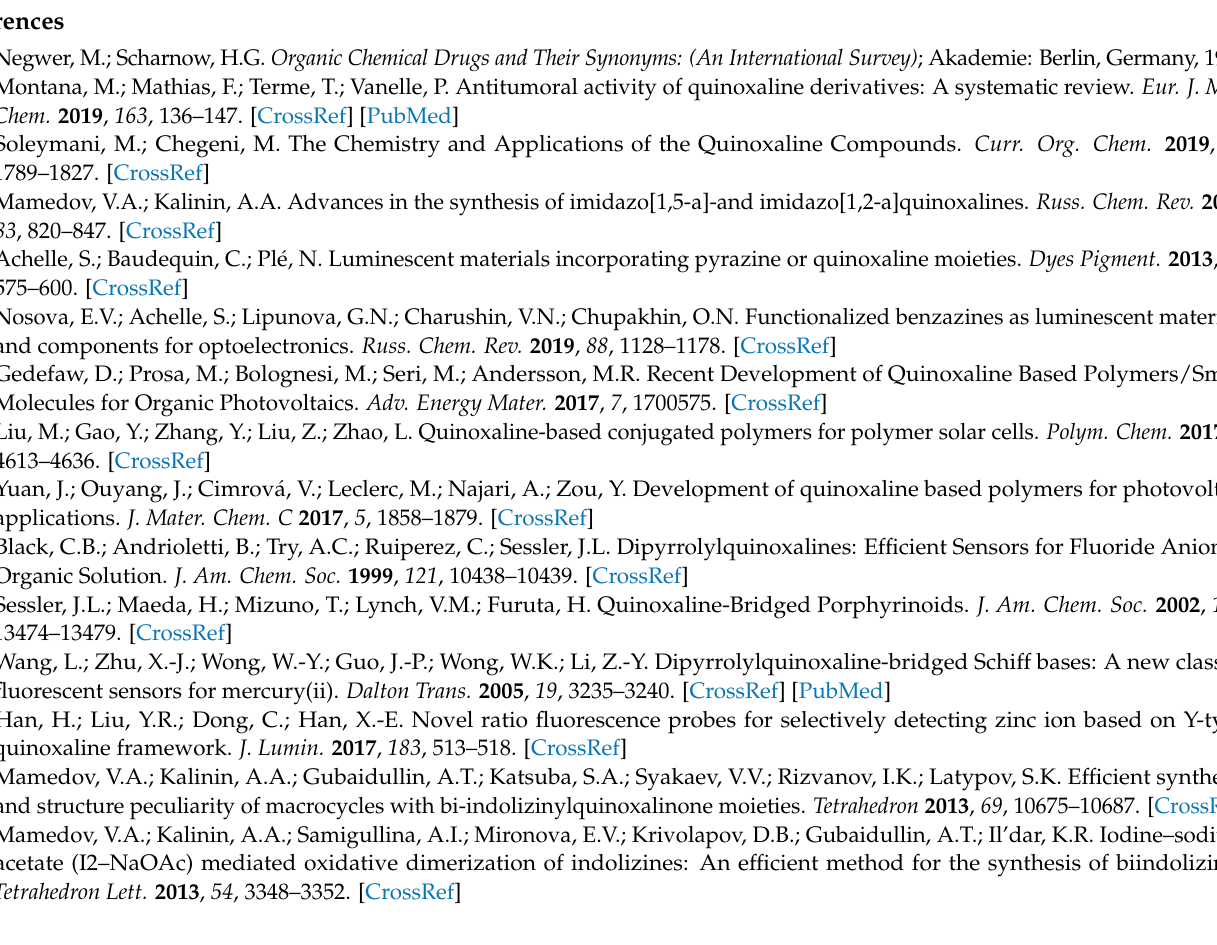
(f) chromophores; Figure S4: Chr-An3/PMMA (40) in the amorphous cell. Figure S5: UV–vis electronic absorption spectra registered before and after poling for films Chr-An1/PMMA (a), Chr-An2/PMMA (b), Chr-An3/PMMA (c), Chr-Car/PMMA (d), Chr-PT/PMMA (e), Chr-TQ/PMMA (f) with chro- mophore load 25 wt.%; Table S1: Polymer films characteristics: poling temperature, T p , order pa- rameter, η , film thickness, and λ max ; Table S2: The coordinates (x,y,z) of the chromophores Chr-An1 , Chr-An2 , Chr-An3 , Chr-Car , Chr-PT , Chr-TQ